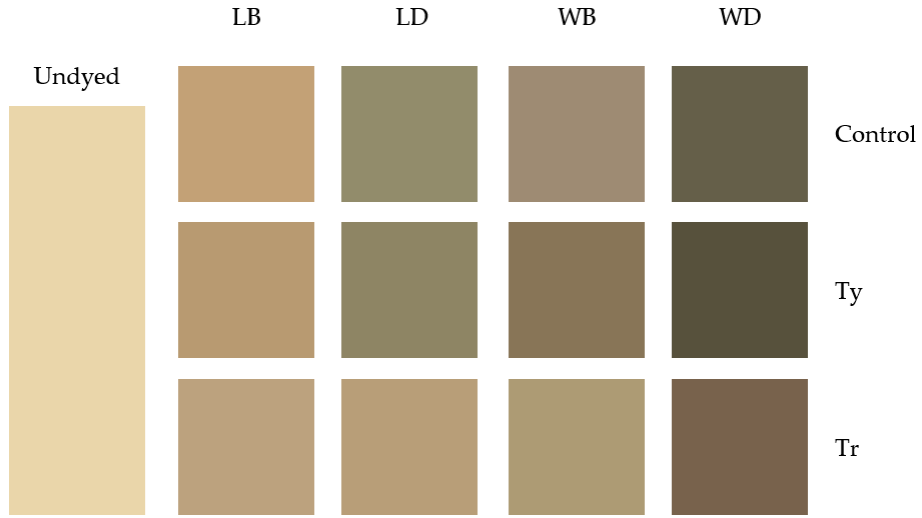
Figure 3. Color simulation of vertical and horizontal dyeing of poplar wood by Lasiodiplodia theo- bromae after 20 and 40 days. (Tyrosinase and tricycle are abbreviated as Ty and Tr in this figure).